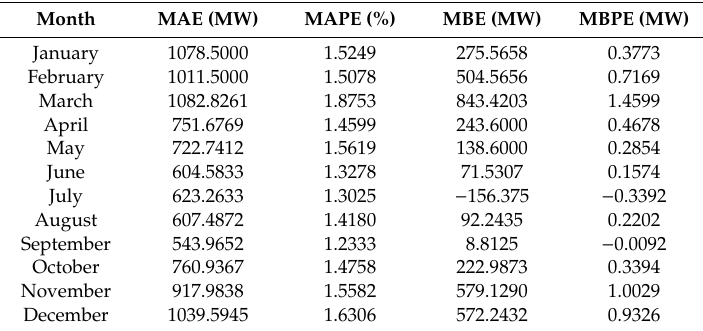
Table 4. Errors provided by the RTE.